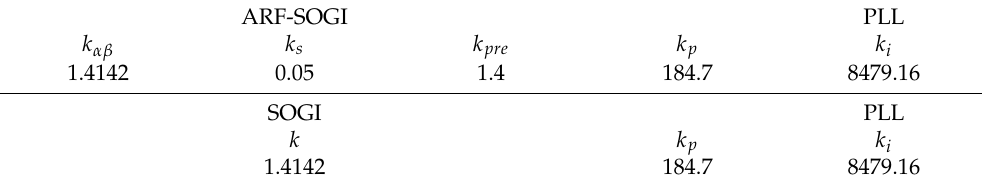
Table 3. Gains for tuning set S3 (typical SOGI bandwidth, typical PLL bandwidth).